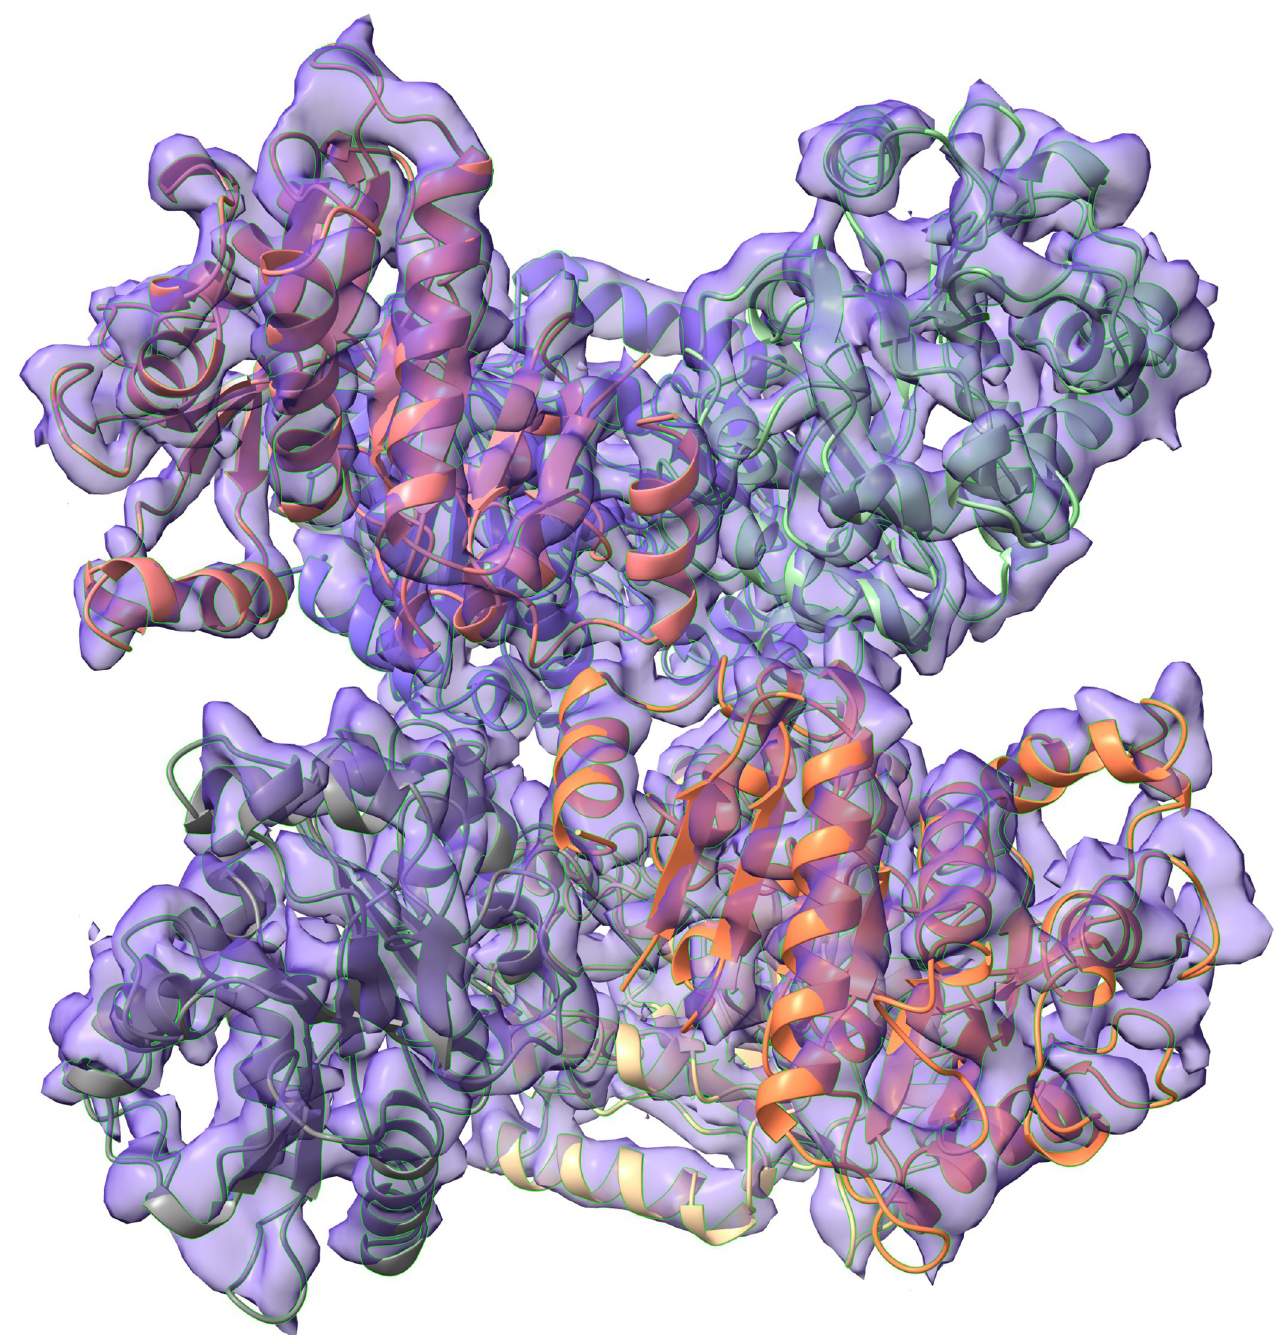
Fig 4. The reconstructed cryo-EM map. The crystallographic hexamer model was fit into the map. The model fits the map well and confirms the hexameric nature of HiNagB. One would generally think a molecule made of the same sequence would crystallize in a space group where the molecular symmetry coincides with the crystallographic symmetry. In the case of Hi NagB, the molecule is a trimer of dimers. Interestingly, the trimer is not